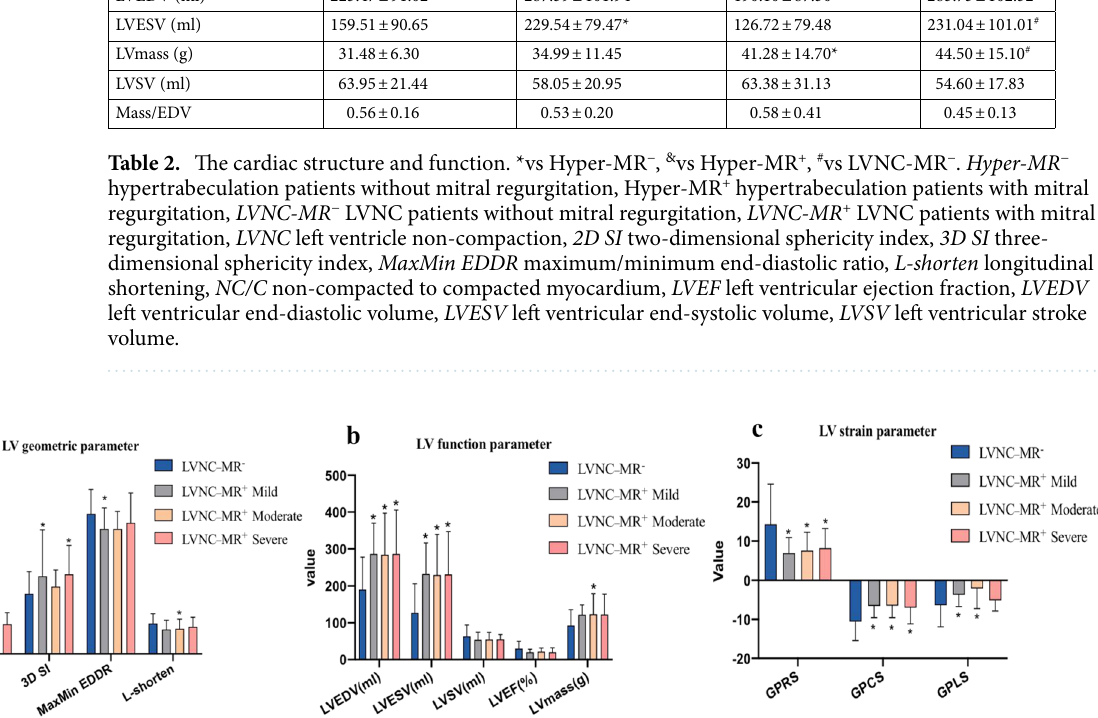
Figure 3. Comparison of left ventricular morphology and function in LVNC patients with different severity of mitral regurgitation. *, P < 0.05 (vs LVNC-MR − ); LVNC-MR − LVNC patients without mitral regurgitation, LVNC-MR + LVNC patients with mitral regurgitation, LVNC left ventricular noncompaction, MR mitral regurgitation, LVEDV left ventricular end-diastolic volume, LVESV left ventricular end-systolic volume, LVSV left ventricular stroke volume, LVEF left ventricular ejection fraction, GPRS global peak radial strain, GPCS global peak circumferential strain, GPLS global peak longitudinal